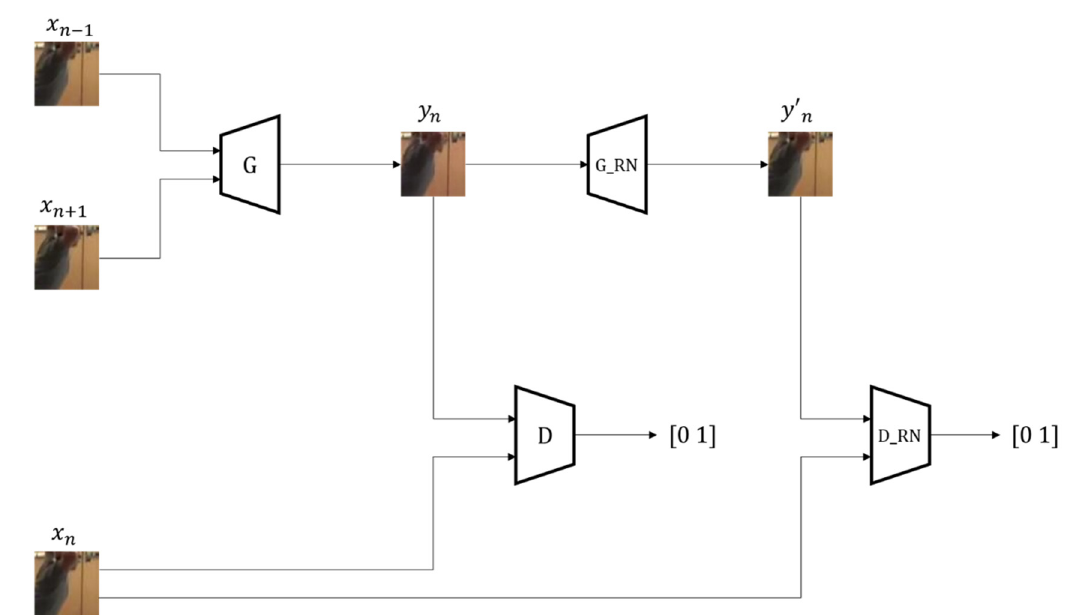
Figure 1. The proposed framework, in which the framework derives the interpolated frame y n from two given ones. Two given input frames x n − 1 and x n + 1 are fed into the generator network G for an interpolated frame. The interpolated frame y n can go through the second generator with the refinement network, denoted by G_RN , for further improvement. D and D_RN represent the discriminators of the original network and refinement network, respectively.